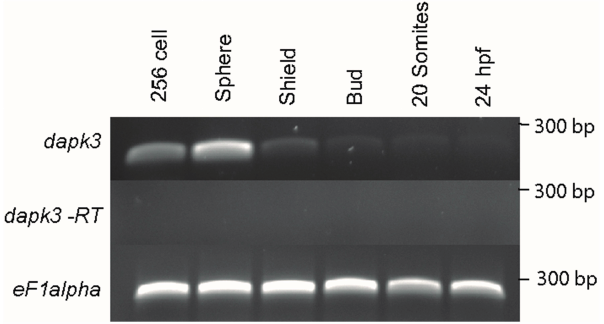
Figure 2. Temporal expression of zipk ( dapk3 ) during early zebrafish development. Gene specific primers were used to detect zipk (286 bp) in various stages of development by RT-PCR. The zipk mRNA was expressed maternally and zygotically throughout early development. Amplification of eF1 alpha and total RNA without addition of reverse transcriptase were used as controls.